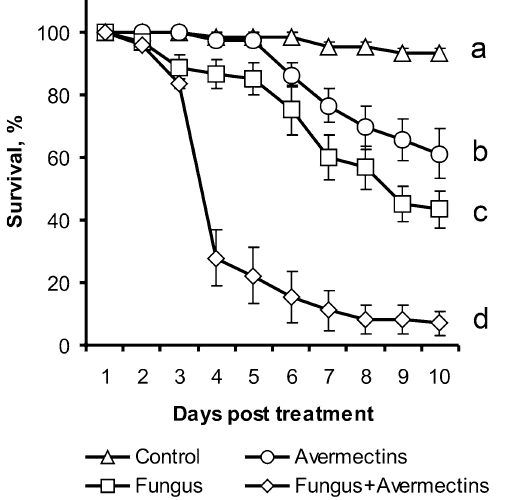
Figure 1. Survival of Colorado potato beetle larvae after topical treatment with M. robertsii conidia, oral administration of avermectins and the combined treatment. Different letters indicate significant differences in survival dynamics (log rank test, χ 2 > 8.4, df = 1, P < 0.005). Synergy was observed from 4 to 10 days ( χ 2 > 10.2 df = 1, P < 0.001).